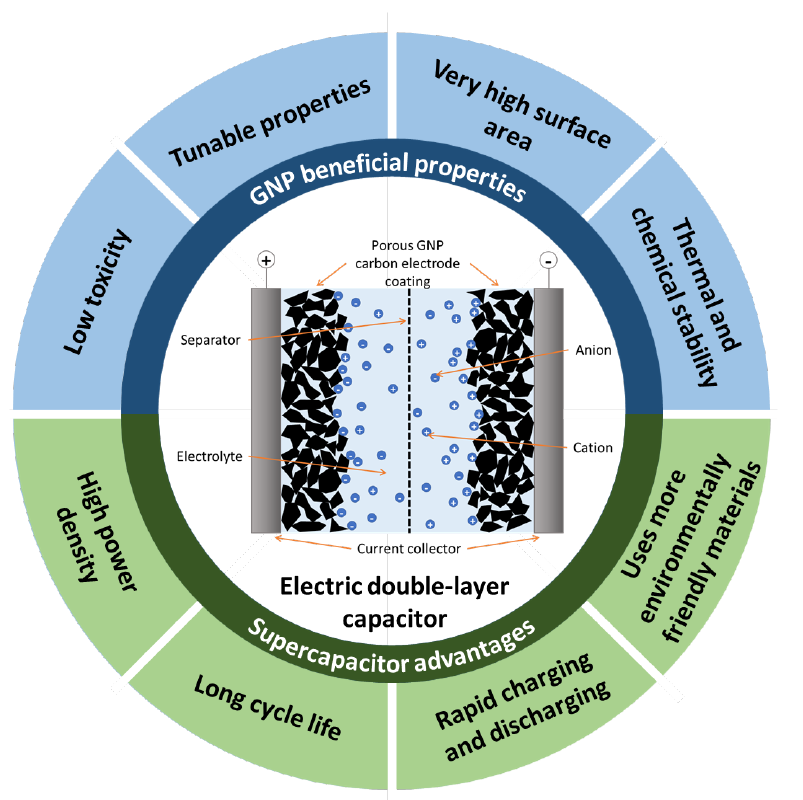
Figure 2. Overview diagram of the content of the paper, including a simple diagram of an electric double-layer capacitor, the beneficial properties of graphene nanoplatelets for supercapacitors, and the advantages for supercapacitors as an energy storage